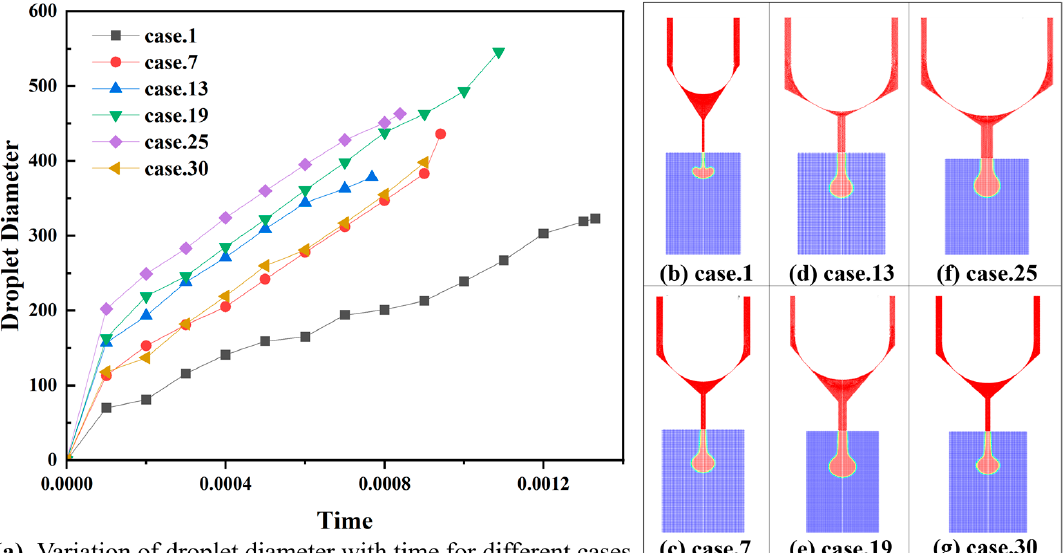
Figure 6. ( a – g ) Variation in jetting velocity with time, for different cases.